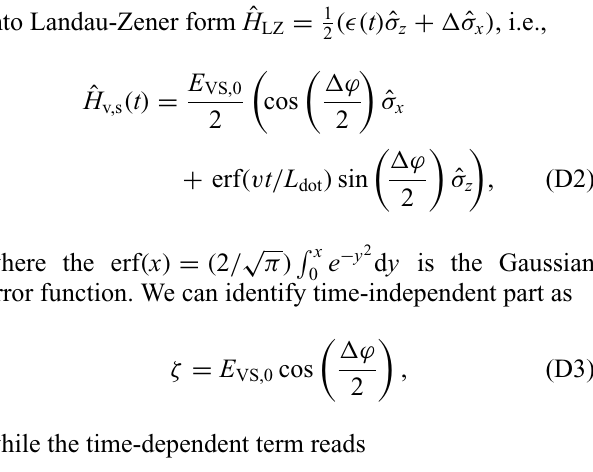
FIG. 18. Occupation of higher valley state after single-step passage Q 1 as a function of shuttling parameter η (lower scale) and valley field angle difference (cid:13)ϕ . Inset: numerical solution to Eq. (22) is compared against effective LZ approximation (30) for selection of angles (cid:13)ϕ/π = 0.3, 0.7, 0.85, 0.95 (dashed lines in larger figure). The upper x axis translates η into electron velocity η/ (cid:2) assuming typical values of L = 20 nm and v = L dot E VS,0 dot E VS,0 = 200 µ